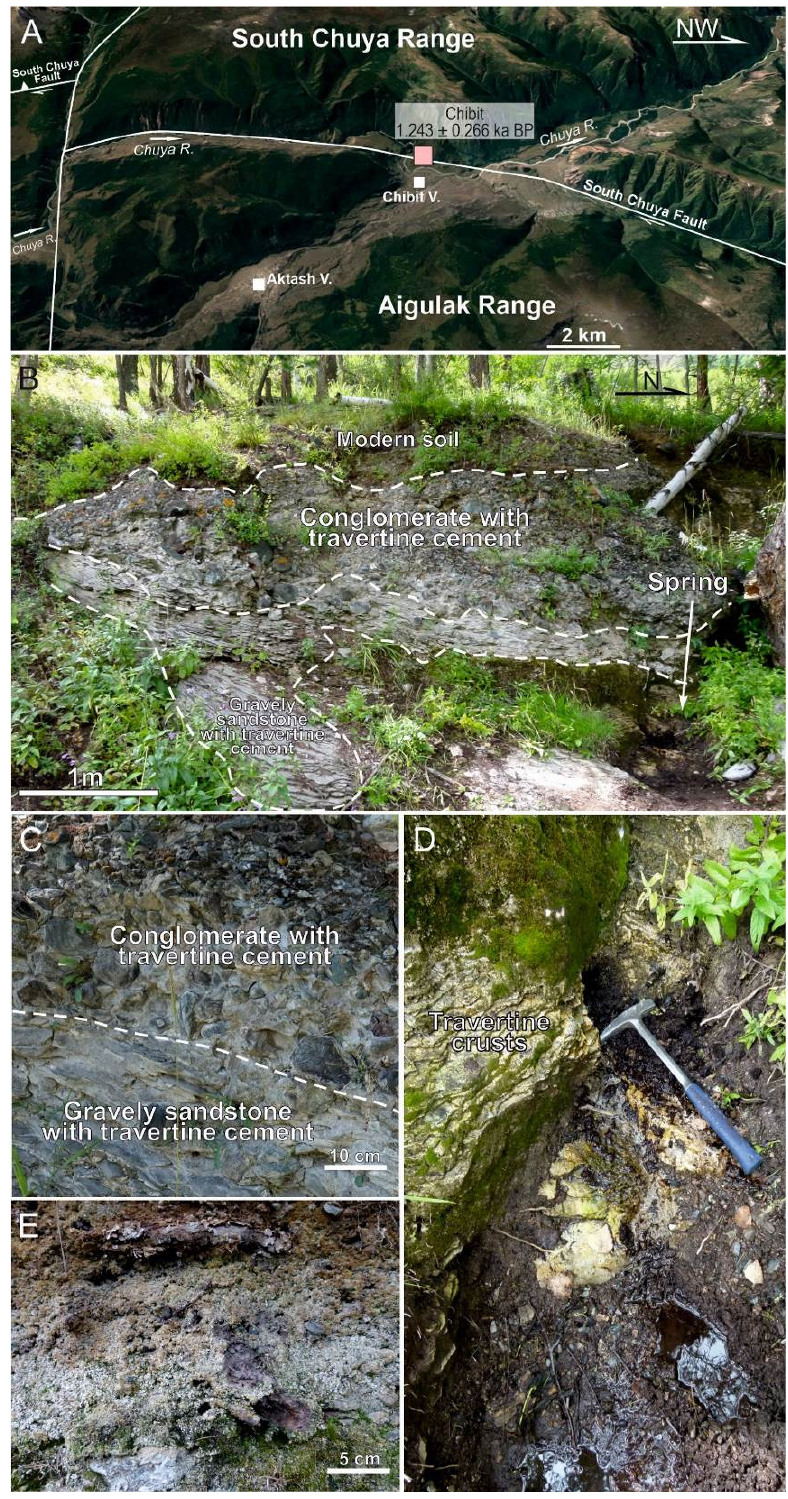
Figure 9. Location and morphology of the Chibit travertines. ( A ) Active faults, location, and U-Th date of the Chibit travertines (50.31277° N, 87.49337° E). ( B , C ) Sandstones and conglomerates formed by the cementation of alluvial deposits by travertines. ( D ) Travertine crusts, formed at the point of discharge of a modern spring. ( E ) Powdery gypsum aggregates covering modern vegetation and